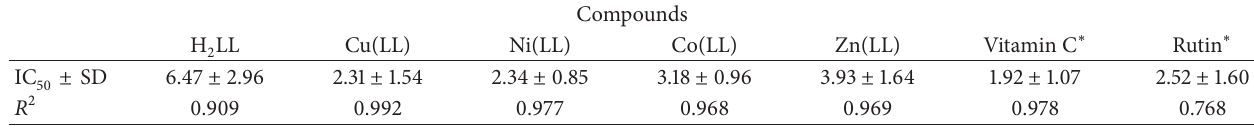
, 𝜇 M) of standard drugs and H 50